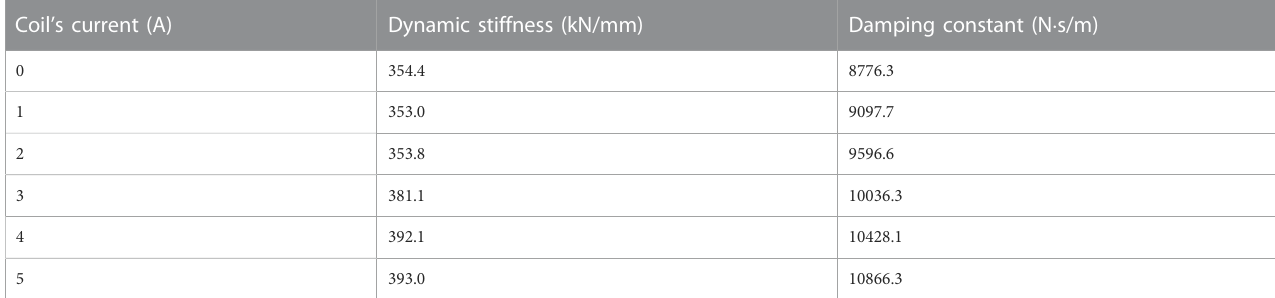
TABLE 3 The dynamic stiffness and damping properties of the MRE railway pad. Coil ’ s current